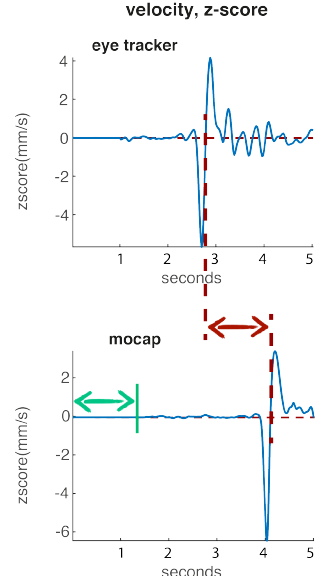
Figure 5. Illustration of the trimming. The dashed red lines indi- cate the sync points for each data stream. The red arrow indicates the temporal difference between both sync points. The green ar- row (same size as the red arrow) indicates the part to be trimmed from the beginning of the mocap